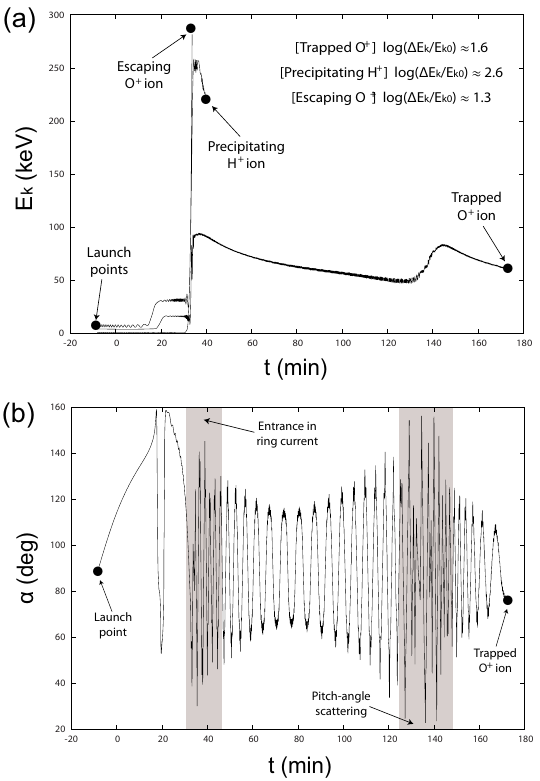
Figure 8. Dynamic evolution of the (a) kinetic energy for the ion orbits analyzed in Figs. 6 and 7 and (b) pitch angle for the trapped O + orbit of Fig.